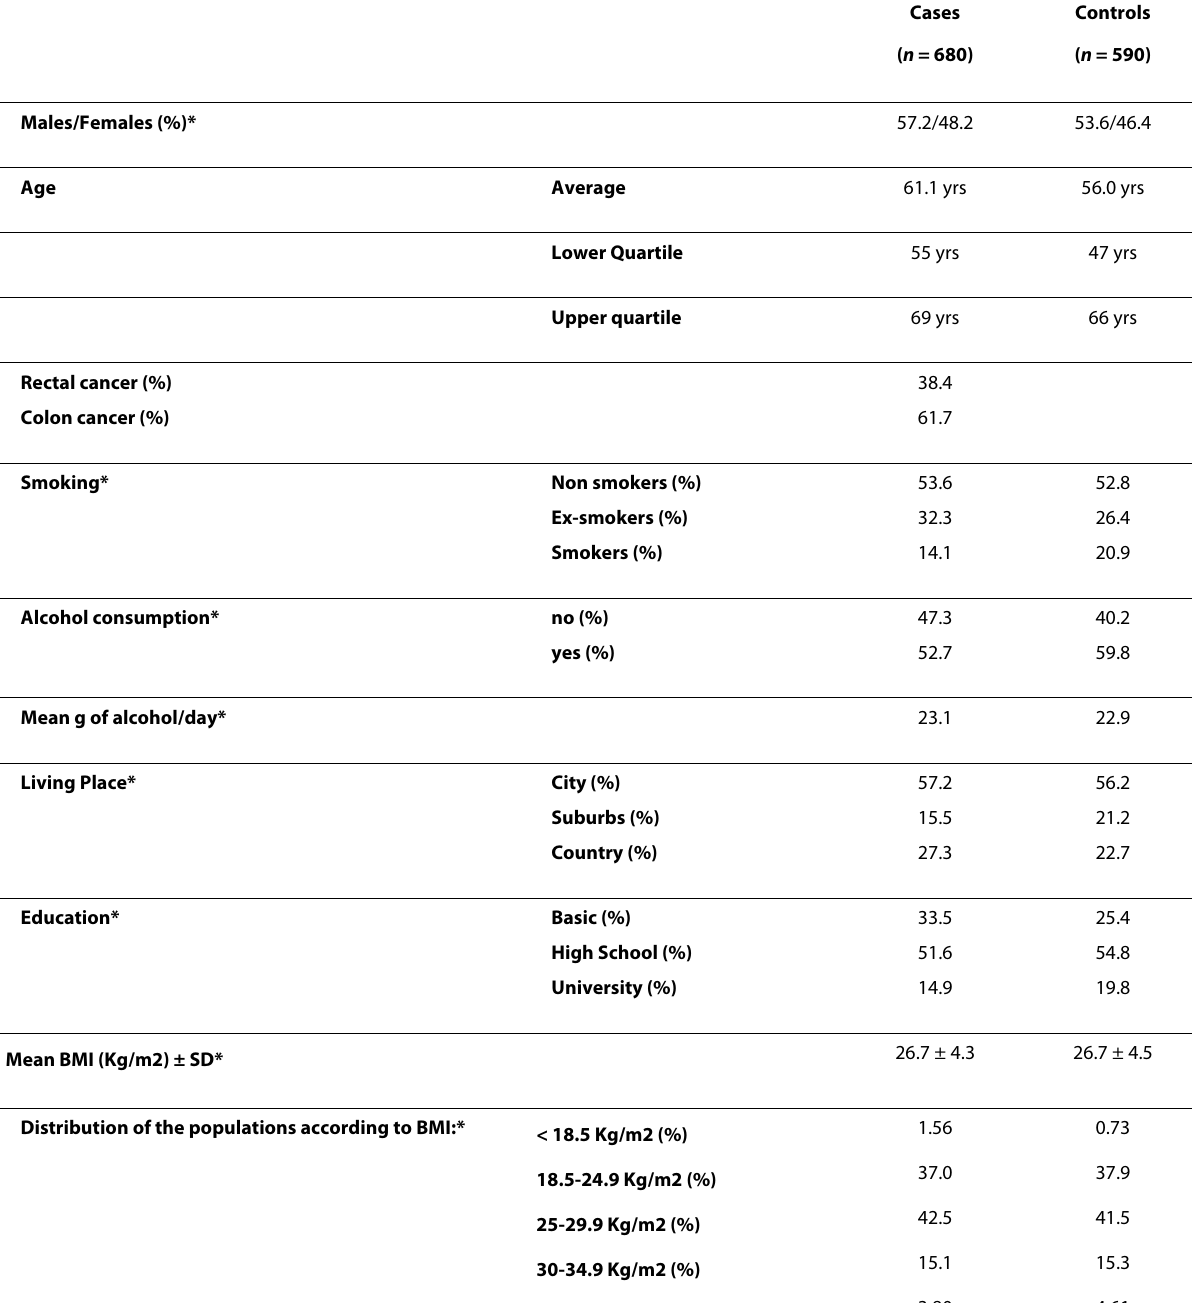
Table 1: Characteristics of colorectal cancer patients and control